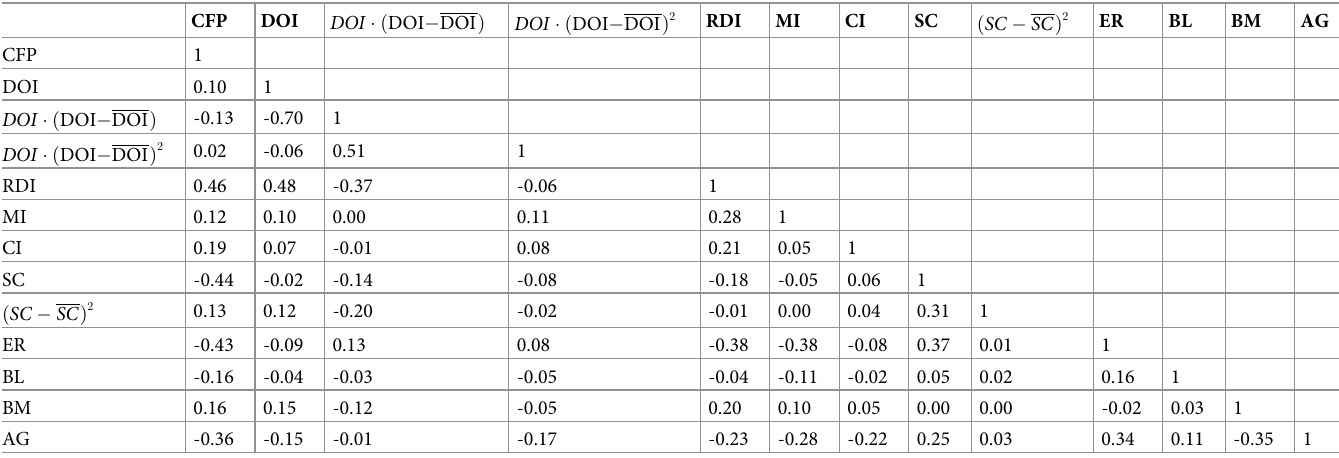
Table 4. Study variable correlation coefficient matrix